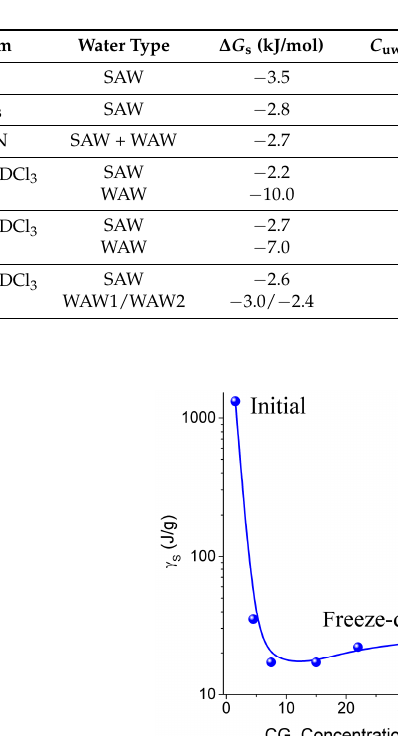
Table 3. Characteristics of water bound to CM1 (samples 1–5) or CM2 (6) at fixed hydration (m) in different media.